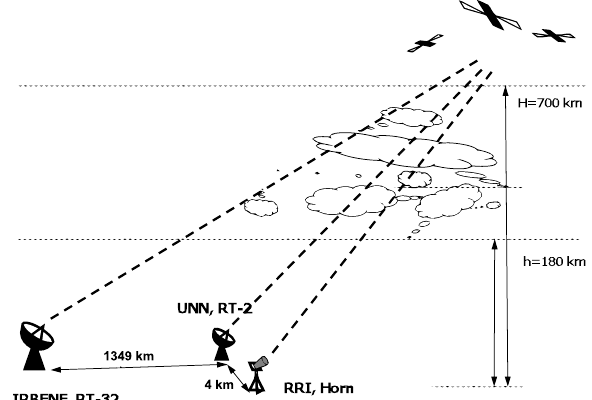
Fig. 1. The scheme of VLBI-experiment on receiving the satellite signals which pass through the arti(cid:12)cial ionospheric turbulence produced by the heating SURA facility.